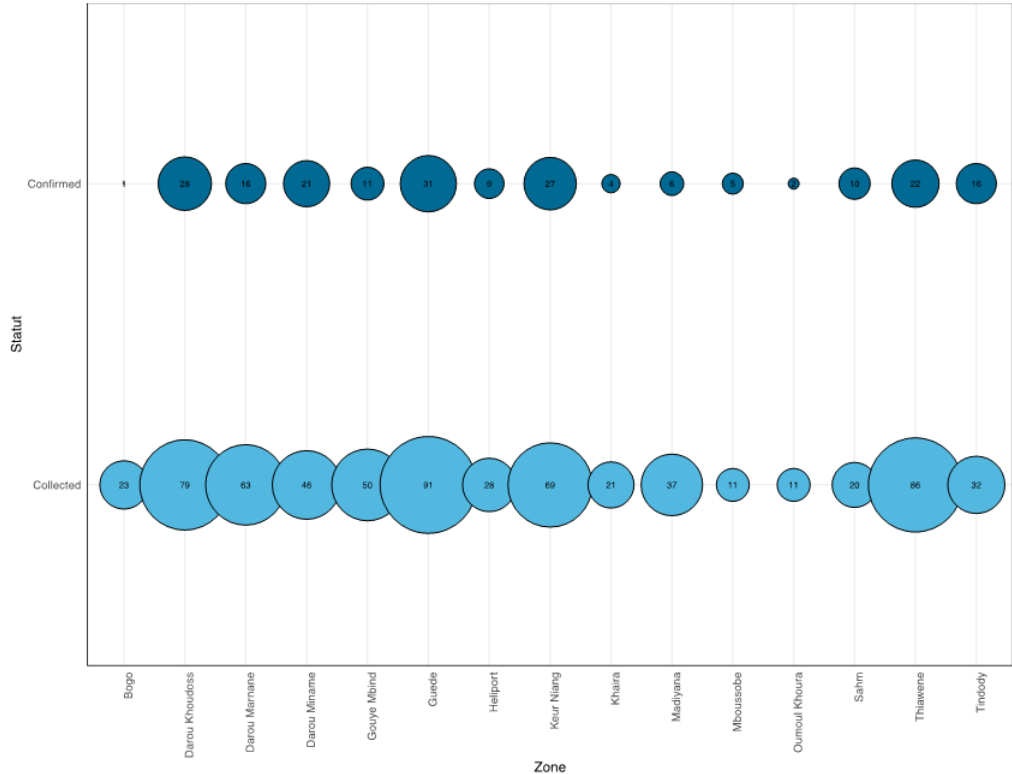
Figure 3. Repartition of suspected and confirmed cases according to healthcare district. We represent only districts with more than 10 suspected DENV cases. Dark blue circles represent the confirmed cases (qRT-PCR and/or IgM detection followed by PRNT) and light blue circles represent the suspected cases. The size of the circles is proportional to the number of cases.